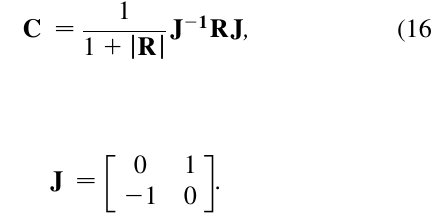
(cid:3) 18 : 226 and Q x